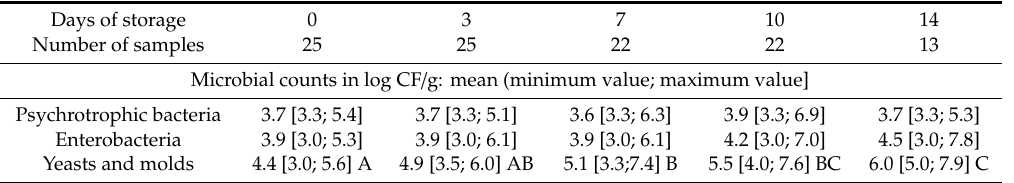
Figure 4. Values for ( a ) firmness, ( b ) a*, ( c ) b* and, ( d ) C* color parameters of 25 minimally-processed pineapple batches during storage at 4°C. Time of storage varies from 0 (D0), 3 (D3), 7 (D7), 10 (D10), pineapple batches during storage at 4 ◦ C. Time of storage varies from 0 (D0), 3 (D3), 7 (D7), 10 (D10), and 14 (D14) days. (+) indicates the mean value, and black dots the outliers. For each parameter, and 14 (D14) days. ( + ) indicates the mean value, and black dots the outliers. For each parameter, different uppercase letters indicate significant differences between storage times. di ff erent uppercase letters indicate significant di ff erences between storage times. Table 4. Changes in microbial population during storage time at 4 ◦